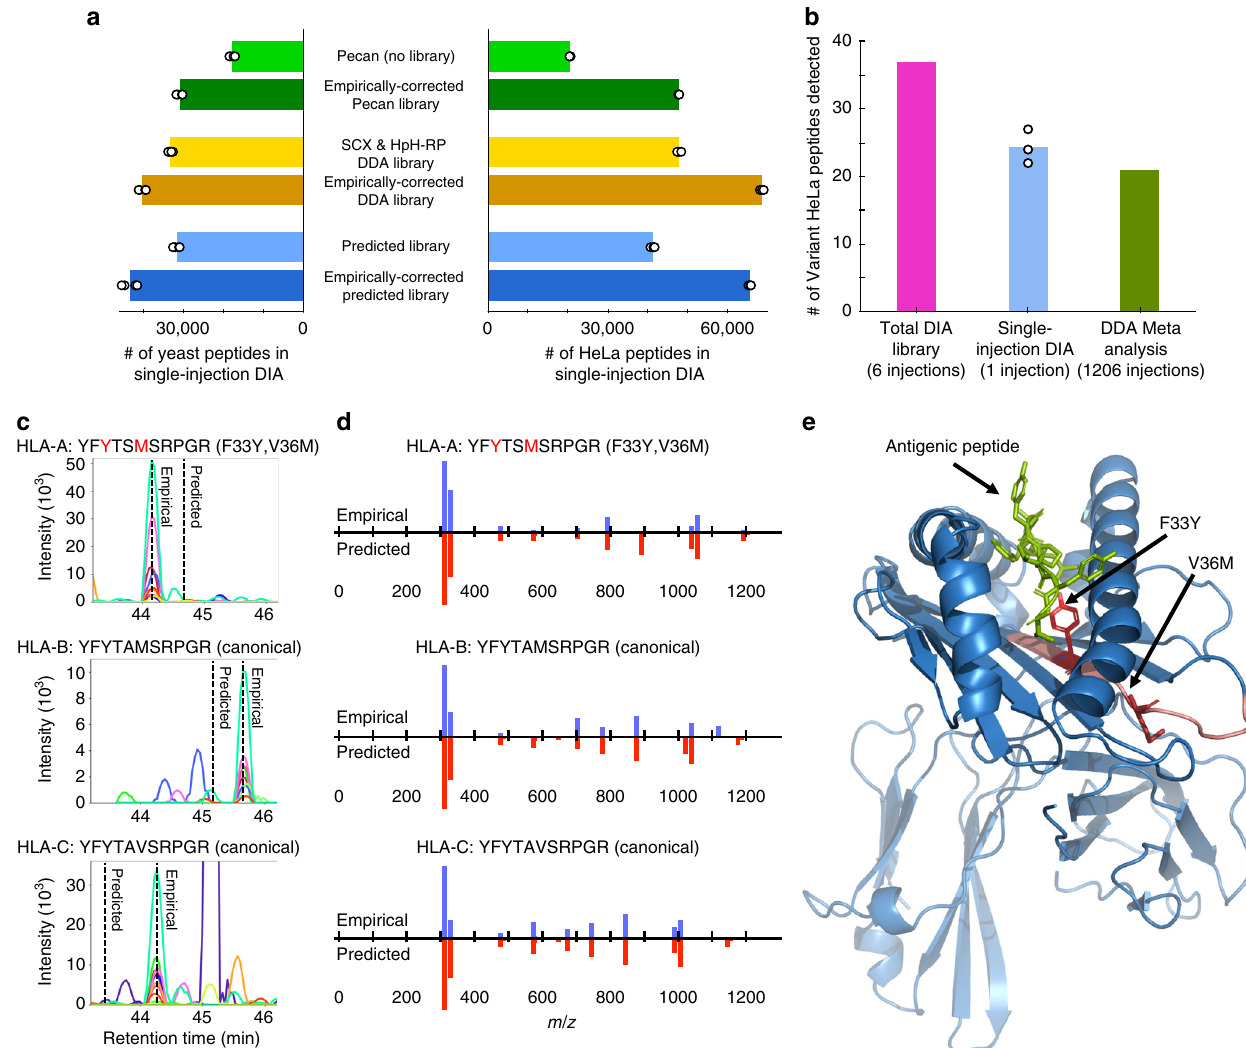
Fig. 3 Empirically corrected libraries improve peptide and missense variant detection rates. a The average number of yeast ( N = 4) and HeLa ( N = 3) peptides in single-injection DIA detected using library-free searching with Pecan, searching with a combined SCX fractionated and high-pH reverse-phase fractionated DDA spectrum library, or searching with a predicted spectrum library, before or after empirical correction with the chromatogram library method. Match-between-runs was not enabled for any search strategy so that replicates are independent measurements demonstrating the technical variability for each approach. b The number of HeLa missense variants detected in the total DIA library, single-injection DIA ( N = 3), or a meta-analysis of 40 published DDA experiments 27 , each fi ltered to a 1% peptide/protein FDR. c Retention time predictions differ somewhat from empirical data from GPF- DIA for homologous peptides: YFYTSMSRPGR from HLA-A (F33Y,V36M), YFYTAMSRPGR from HLA-B, and YFYTAVSRPGR from HLA-C. d Relative + 1H y-type and b-type fragmentation patterns above 200 m / z for the same peptides are shown as butter fl y plots with empirical intensities (blue) above predicted intensities (red). e All three peptides are in the HLA peptide binding/presentation region, as indicated by YFYTSMSRPGR (red) in HLA-A (blue) relative to an antigenic peptide (green) in PDB structure 1AO7. Source data are provided as a Source Data fi